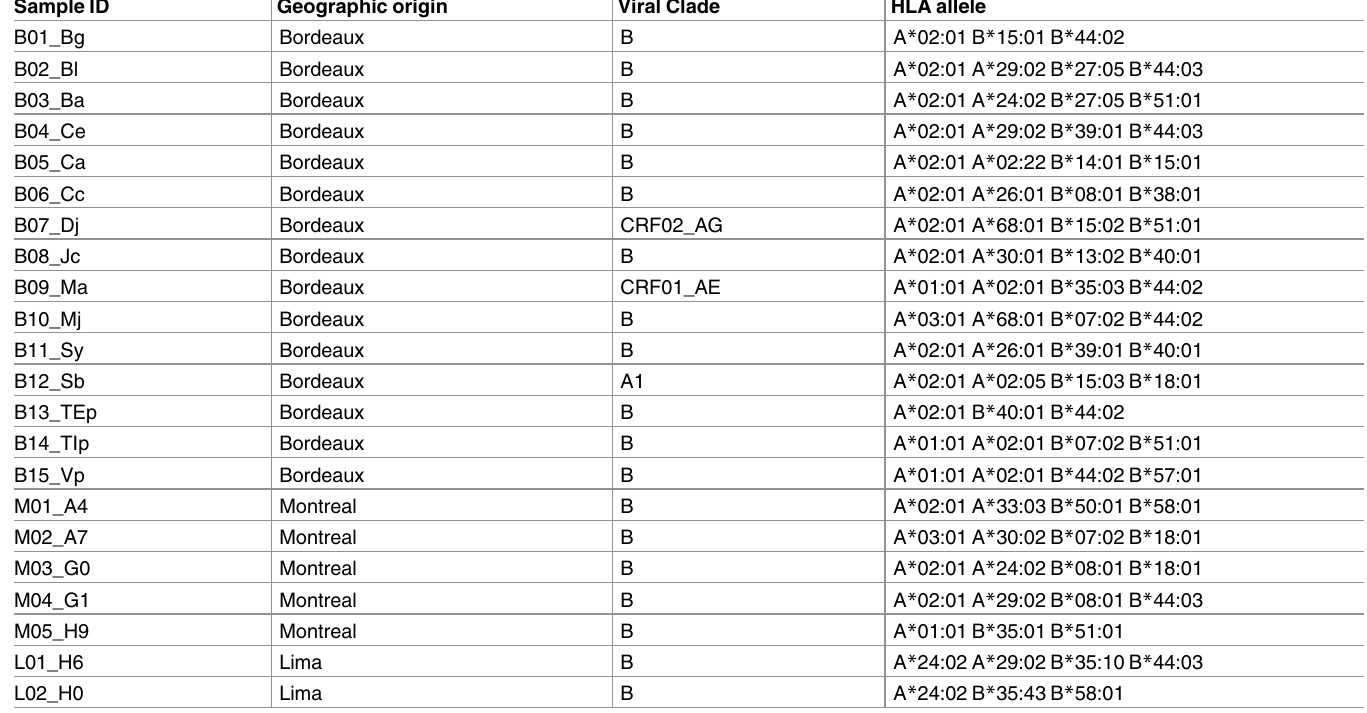
Table 1. Patients’ characteristics. The viral clade and HLA alleleA and B typing results for each individual from the French, Canadianor Peruviancohort are presented. Sample